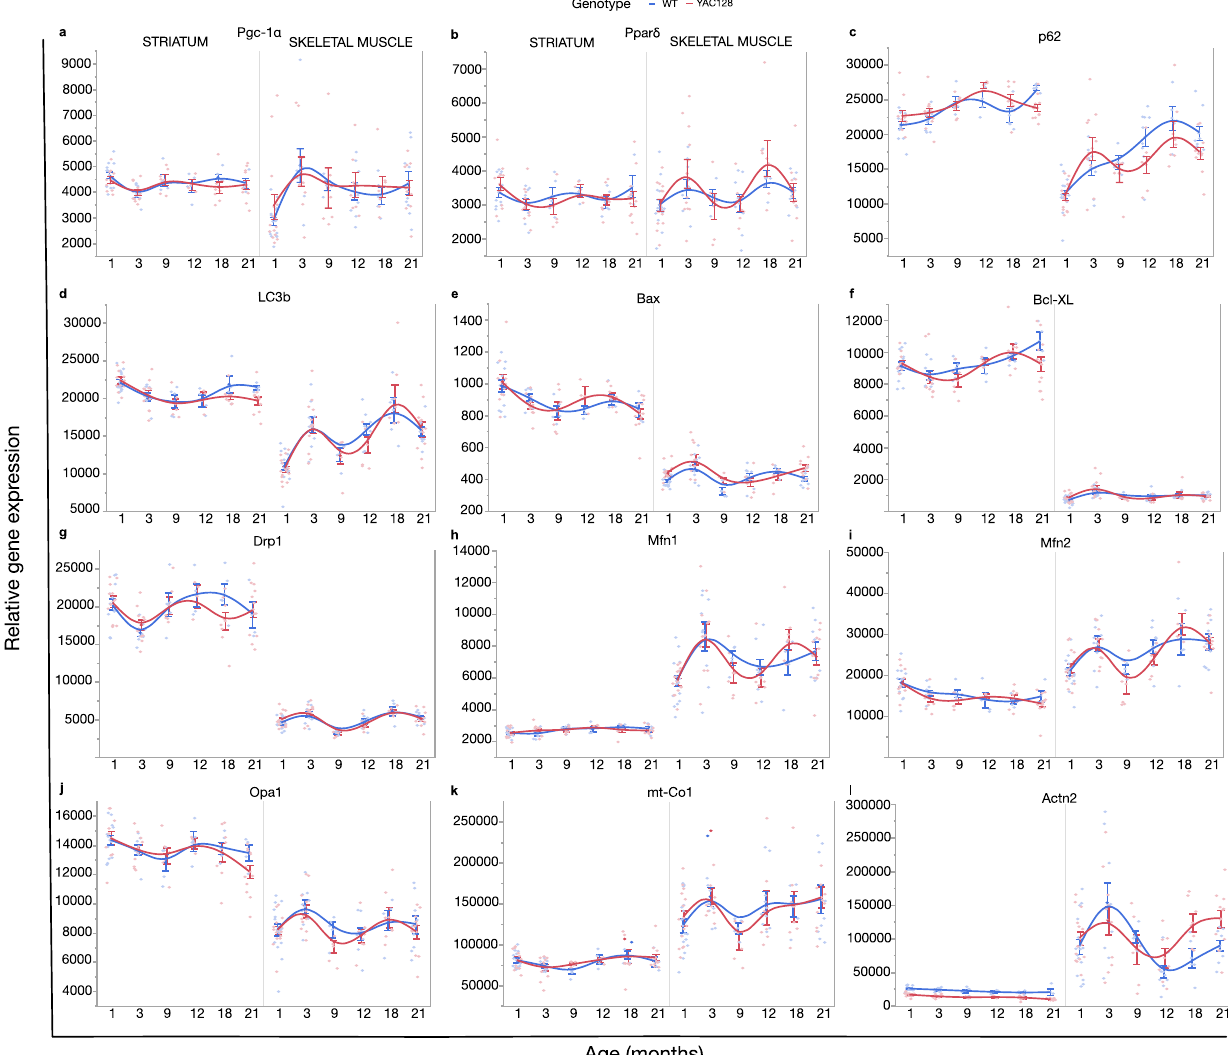
Fig. 6 Age and genotype effects on transcript levels of genes involved in mitochondrial dynamics. Lines represent the fi tted means of WT (blue) and YAC128 (red) with s.e.m. a Age and genotype had no effect on Pgc-1 α levels in striatum. Age-related changes on Pgc-1 α transcript levels with no genotype effect in skeletal muscle. b Age and genotype had no effect on Ppar δ transcript levels in striatum and skeletal muscle. c Age-related changes in p62 transcript levels with no genotype effect in striatum and skeletal muscle. d Age-related changes in LC3b transcript levels with no genotype effect in striatum and skeletal muscle. e Age-related changes in Bax transcript levels with no genotype effect in striatum. Age- and genotype-related changes in Bax transcript levels in skeletal muscle. f Age-related changes in Bcl-xL transcript levels with no genotype effect in striatum. Age and genotype had no effect on Bcl-xL expression in skeletal muscle. g Age-related changes in Drp1 transcript levels with no genotype effect in striatum and skeletal muscle. h Age-related changes in Mfn1 expression with no genotype effect in striatum and skeletal muscle. i Age-related changes in Mfn2 expression with no genotype effect in striatum and skeletal muscle. j Age- related changes in Opa1 transcript levels with no genotype effect in striatum and skeletal muscle. k Age and genotype had no effect on mt- Co1 transcript levels in striatum. Age-related changes in mt-Co1 transcript levels in skeletal muscle. l Age- and genotype-related changes in Actn2 transcript levels in striatum. Age-related changes in Actn2 transcript levels in skeletal muscle. Sample size ranges from n = 3 – 16. See also Supplementary Tables 4 –